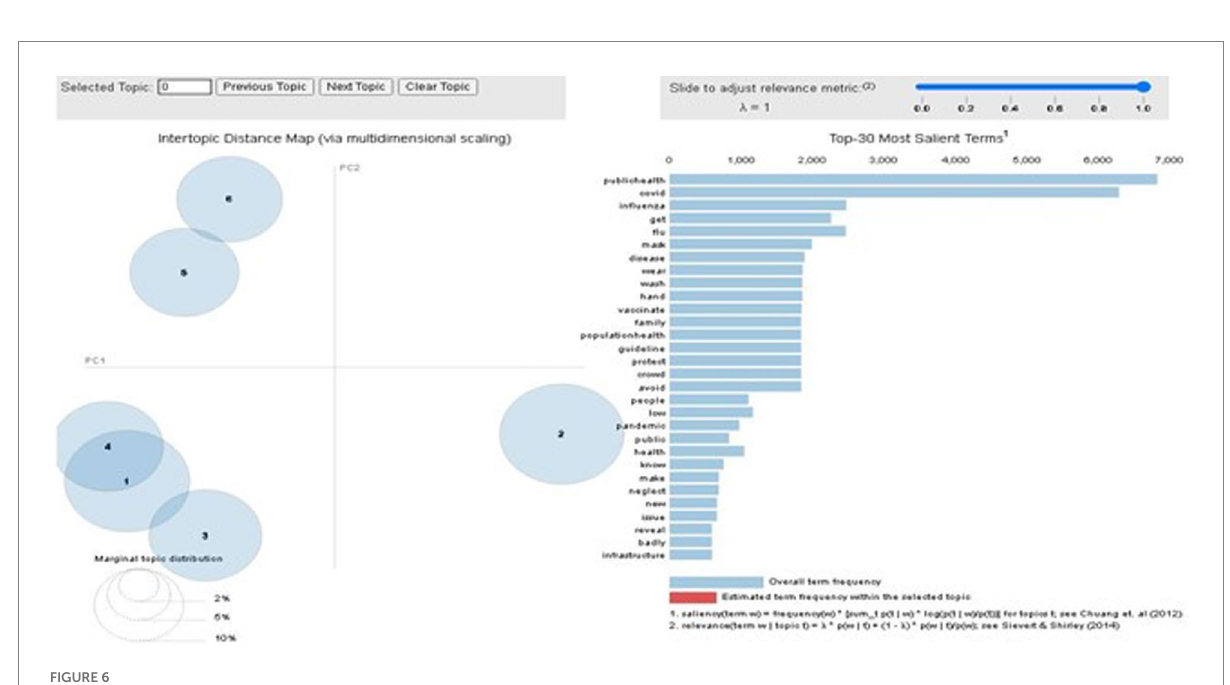
FIGURE 6 Negative topic words in Gensim LDA model.